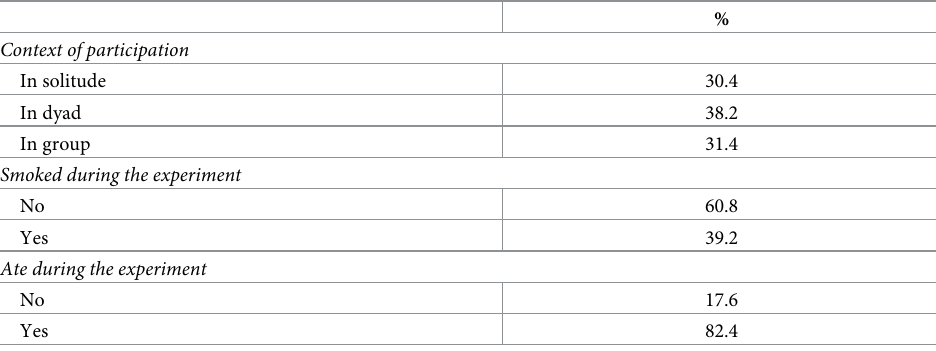
Table 2. Context